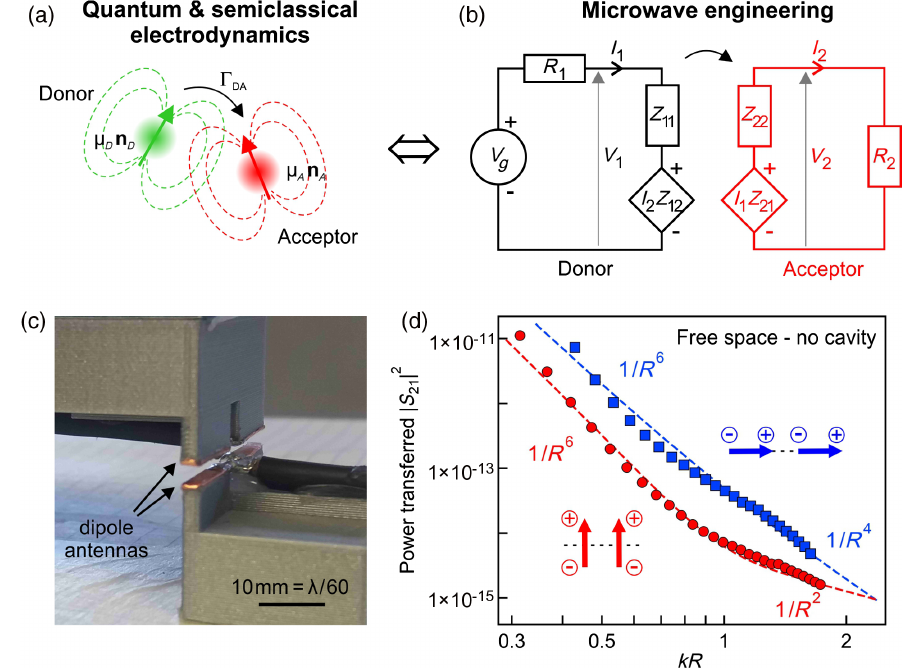
FIG. 1. (a) Quantum-mechanical description and (b) microwave engineering descriptions using a two-port network, of dipole-dipole energy transfer. (c) Photograph of the two dipoles set in parallel orientation. The dipole length is 30 mm and corresponds to λ = 20 . (d) Calibration of the power transferred versus the dipole-dipole separation R in free space. Markers are experimental data for parallel dipoles (red) and aligned dipoles (blue) and dashed lines are theoretical predictions from Green ’ s function theory